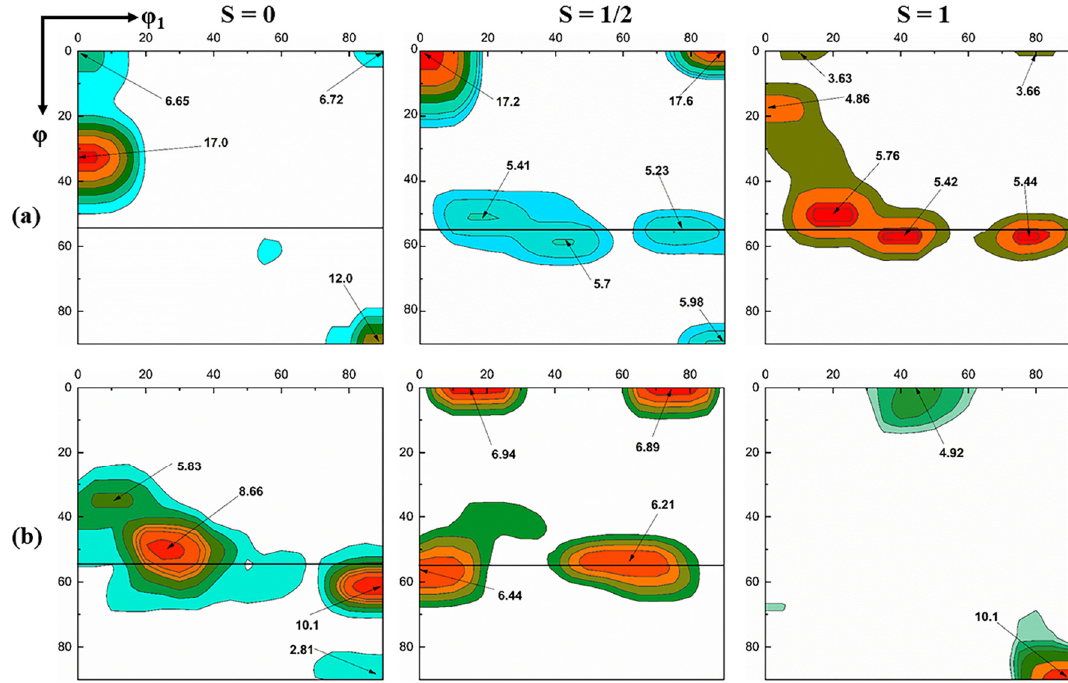
Figure 8. ϕ 2 = 45 ◦ sections of the ODF at di ff erent layers after annealing (ASR). ( a ) Annealing at 650 ◦ C; Figure 8. φ 2 = 45° sections of the ODF at different layers after annealing (ASR). ( a ) Annealing at 650 ( b ): annealing at 750 ◦ °C; ( b ): annealing at 750 °C.